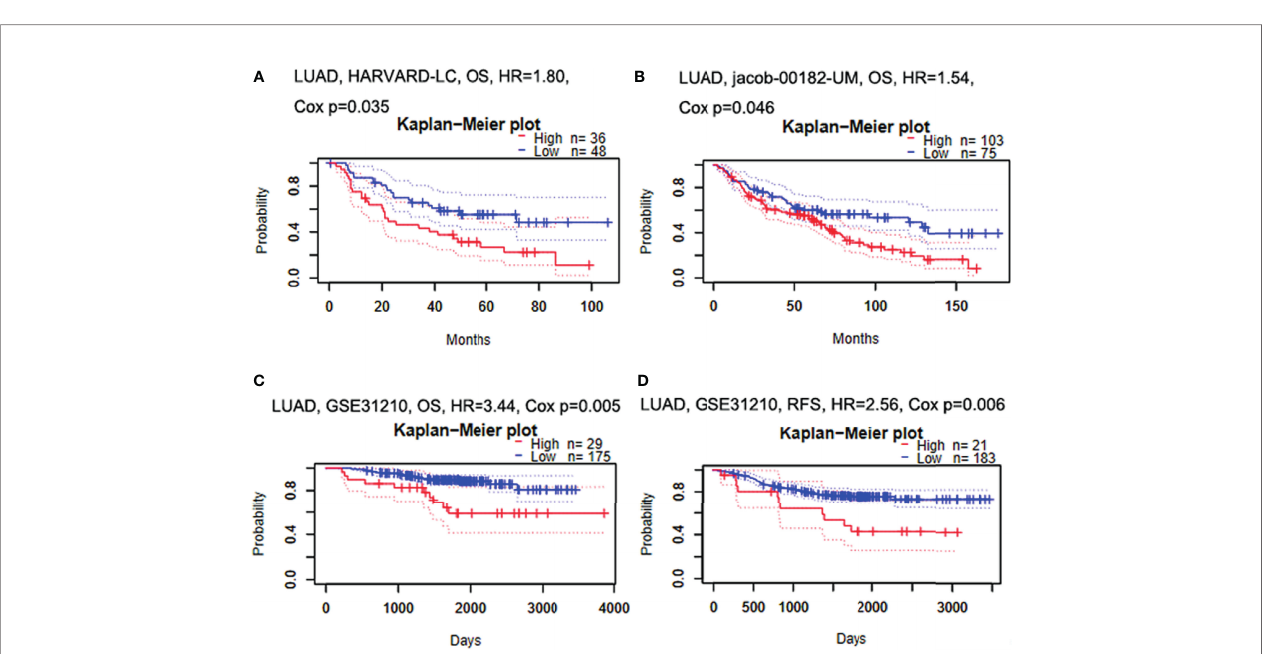
FIGURE 2 | The relationship between GBE1 expression and prognosis in LUAD analyzed by PrognoScan database (A – D) . (A) In the HARVARD-LC cohort, high expression of GBE1 predicted a poor OS in LUAD (HR = 1.80, p = 0.035). (B) In the jacob-00182-UM cohort, high expression of GBE1 predicted a poor OS in LUAD (HR = 1.54, p = 0.046). (C) In the GSE31210 cohort, high expression of GBE1 predicted a poor OS in LUAD (HR = 3.44, p = 0.005). (D) In the GSE31210 cohort, high expression of GBE1 predicted a poor RFS in LUAD (HR = 2.56, p = 0.006). OS, overall survival; RFS, recurrence-free